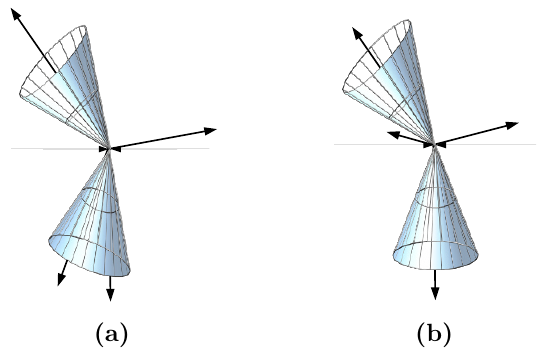
Figure 2 . An illustration of 2-jet NNLO con(cid:12)gurations that contribute to the p T imbalance between the leading and subleading jet with arrows representing partons and cones representing jets.